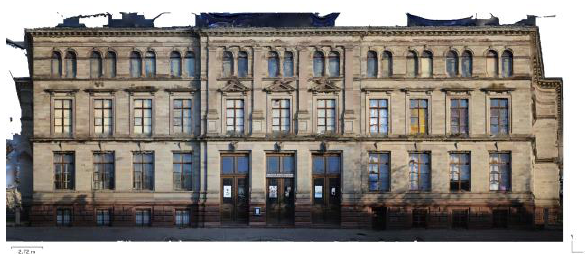
Figure 2. Depth map of the Zoological Museum façade generated by terrestrial photogrammetry used as input.